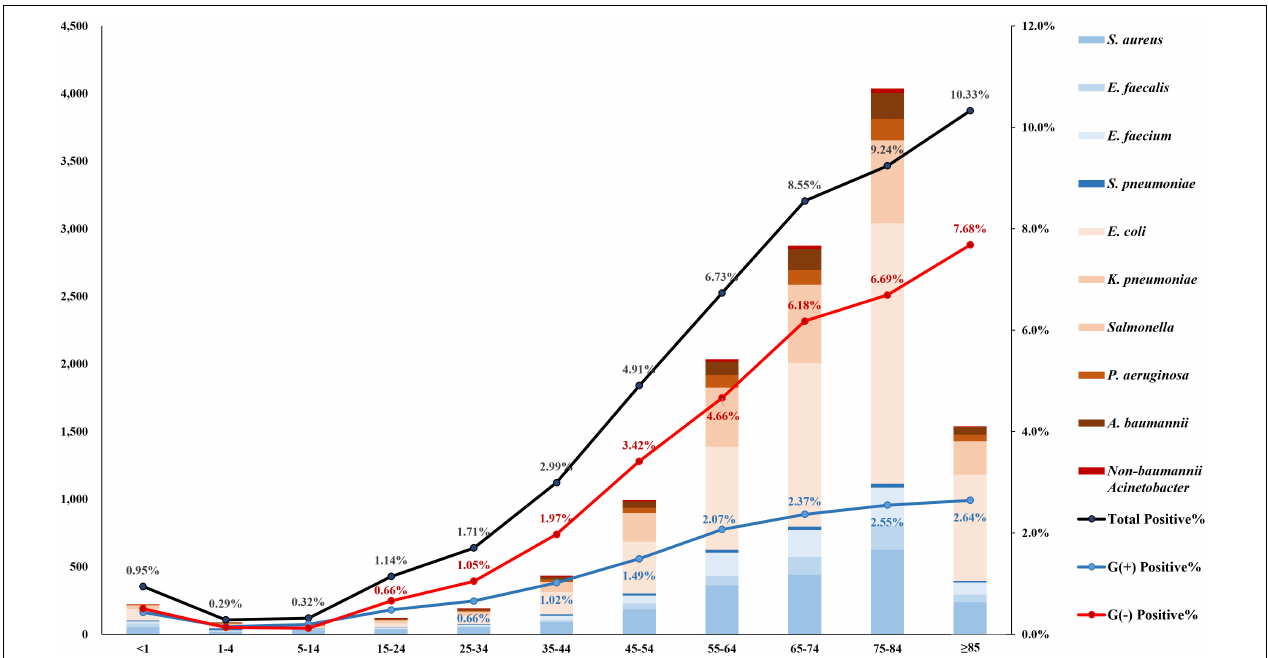
FIGURE 3 | Number of patients with bloodstream infection by target pathogen. The rate of blood culture positivity for target pathogens was the lowest at 0.29% in the age group 1–4, and it increased as the patients became older, up to 10.33% in the age group ≥ 85. The bar represents the number of patients by pathogen. The black line is the percentage of patients positive for target pathogen, the blue line is that for gram-positive pathogens, and the red line is that for gram-negative pathogens.